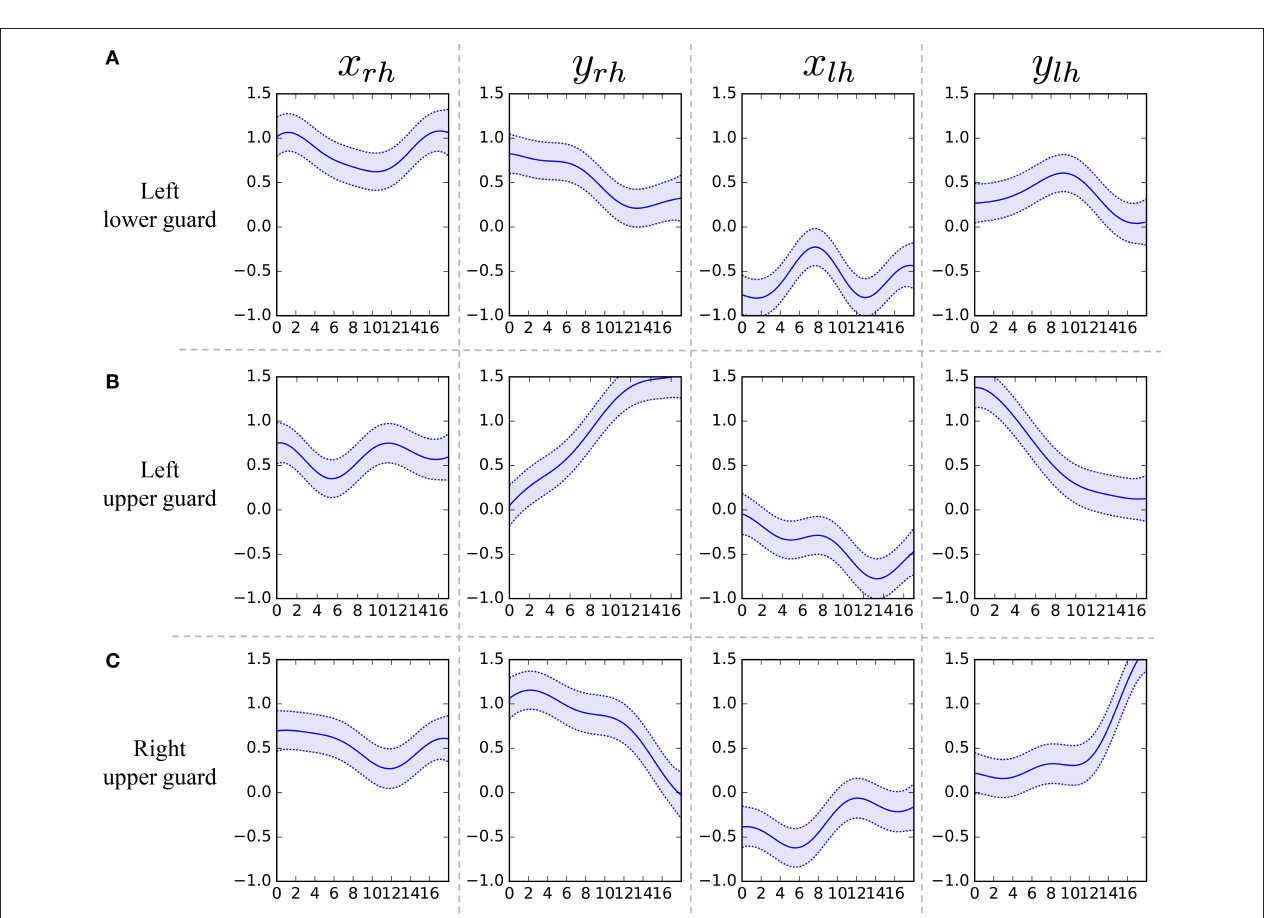
FIGURE 13 | Learned Gaussian processes for left lower guard, left upper guard, and right upper guard.